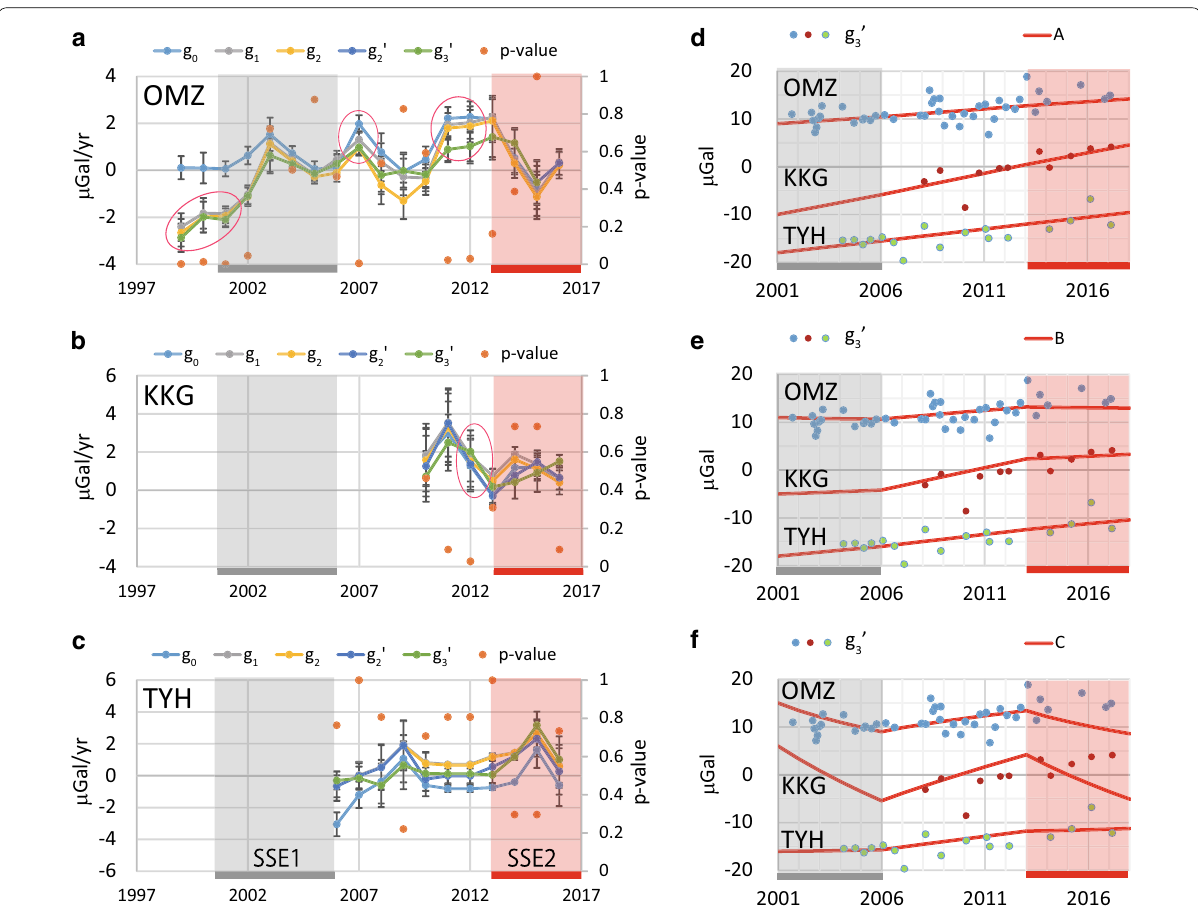
Fig. 3 The rate changes for gravity and model comparisons. a – c Linear trends for the gravity changes obtained by a 4-year moving average. The gray and red colors denote the periods of the LSSEs. The orange circles show the p value for the trend of g 3 ′ . d – f A comparison of the poroelastic models A-C with the gravity change after all the corrections (g 3 ′